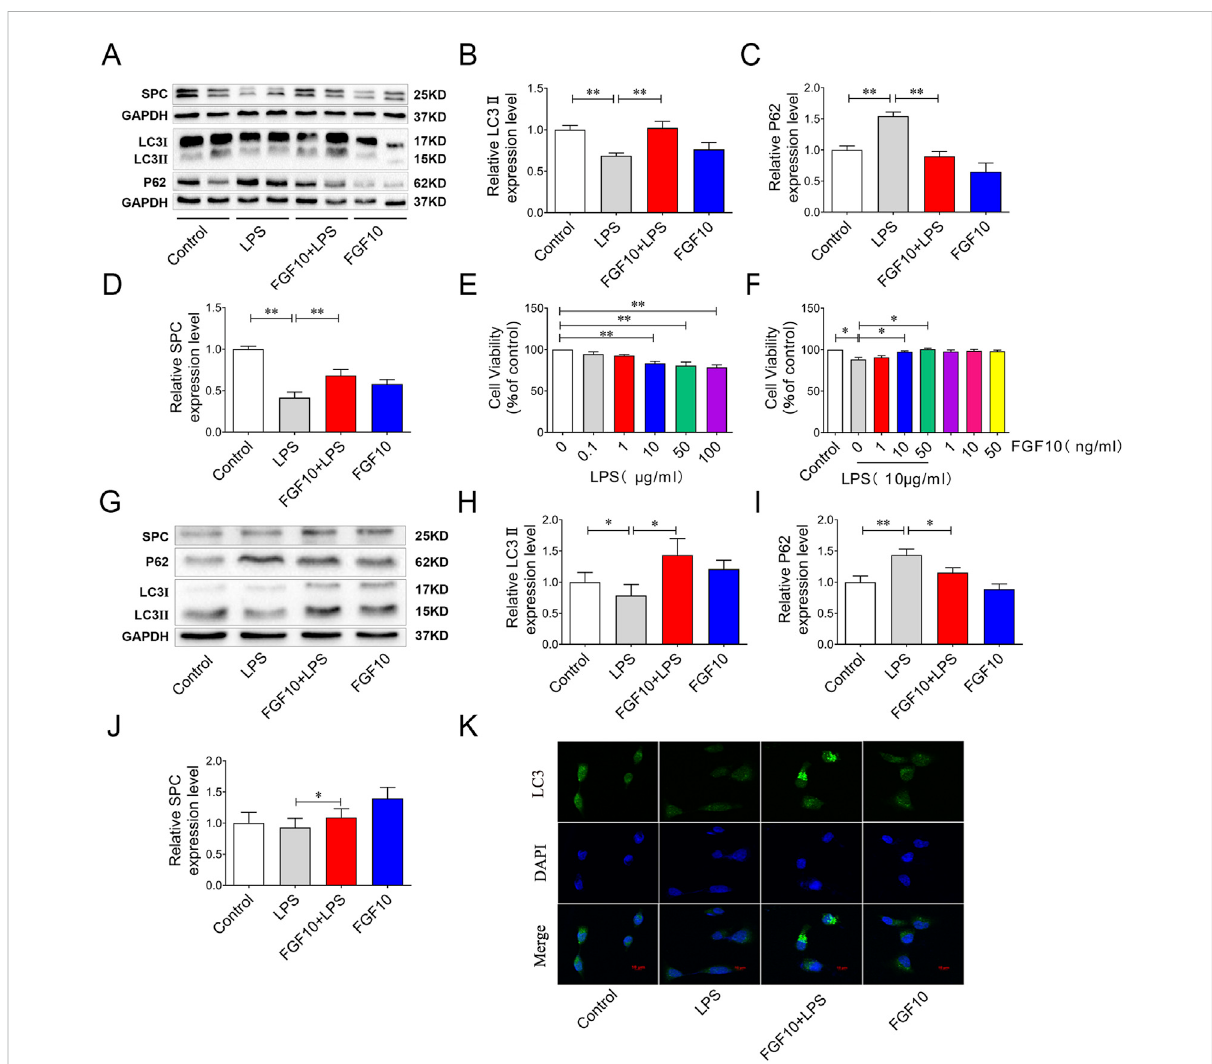
FIGURE 3 FGF10promotes autophagyandtheregenerationofalveolarepithelialcellsinLPS-inducedlunginjury. (A) TheexpressionofLC3,P62,andSPC in mice was detected by Western blotting. (B – D) Quantitative analyses of LC3, P62, and SPC protein. (E) The viability of AECs with different concentrationsofLPSadministrationwasdetectedbyCCK-8. (F) AfterexposuretoLPSandFGF10,theviabilityofAECsweredetectedbyCCK-8. (G) The expression of LC3, P62, and SPC in AECs was detected by Western blotting. (H – J) Quantitative analysis of LC3, P62, and SPC protein. (K) TheexpressionofLC3(green)ofAECswasanalyzedbyimmunostaining(magni fi cation×400).Thedatawerepresentedasthemean±SEM,n=3 – 5. * p < 0.05, * * p <